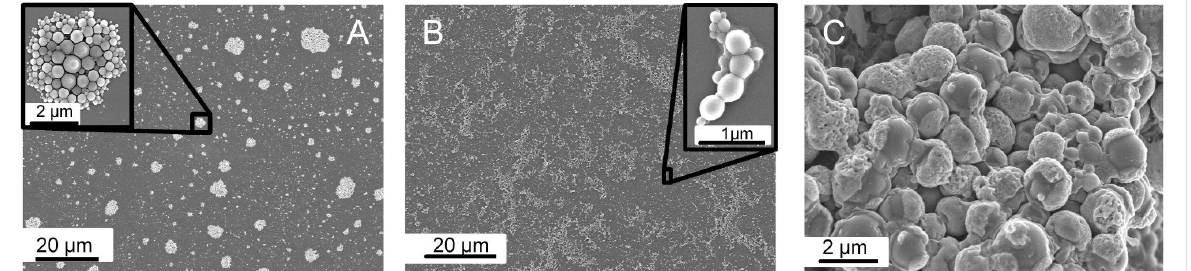
Figure 4: SEM micrographs of (A) unfunctionalized SiC-SDS spheres, (B) SiC-Acr/CeO 2 spheres prepared by molecular bonding approach and (C) SiC/CeO